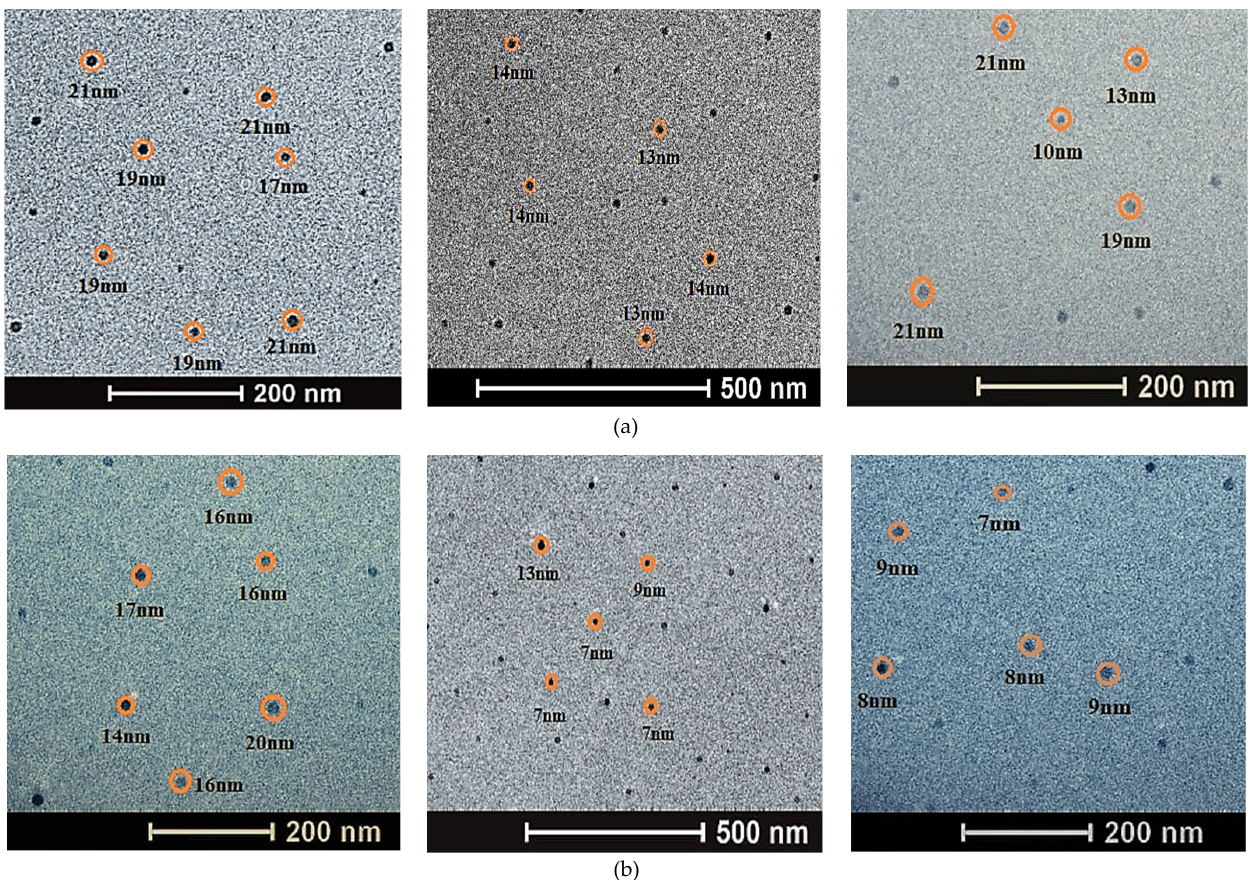
Figure 6. ( a ) The 0.1 mol/L zinc oxide nanoparticles. ( b ) The 0.1 mol/L manganese oxide II nanoparticles.